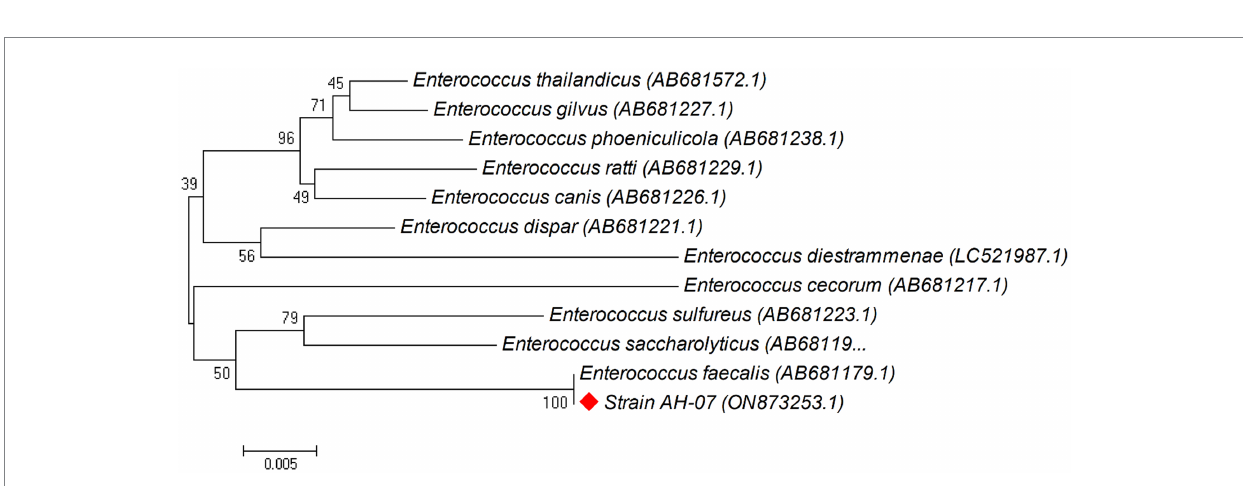
FIGURE 3 Phylogenetic relationship between the strain AH-07 and other 16S rRNA gene sequences of published strains. In the phylogenetic tree, AH-07 and Enterococcus faecalis were clustered together as one clade. The scale bar corresponds to a 0.005 nucleotide substitution per sequence position. The number in parentheses represents the accession number in